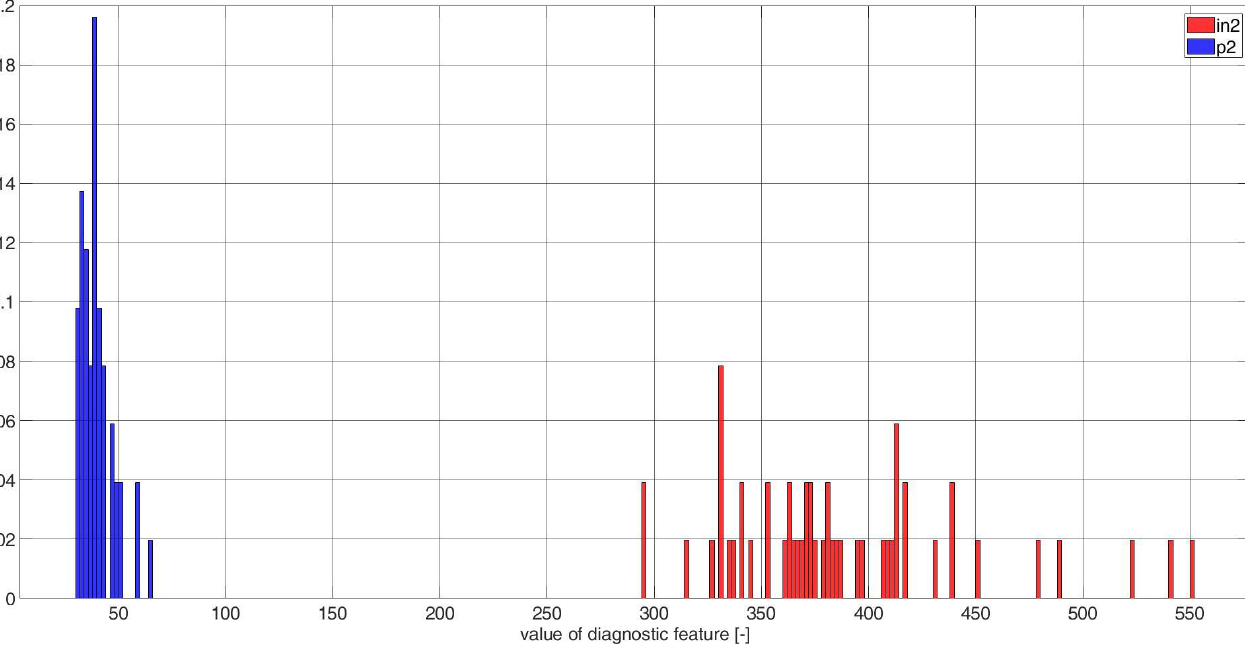
Figure A16. Histograms of diagnostic features based on the CCSM3 (correlation number is 13—Table A1) bearings in2 and p2.